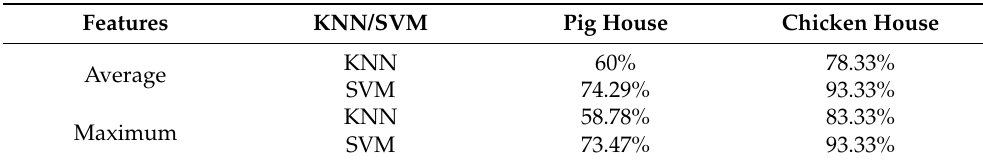
Table 8. The accuracy for odor classification in different sampling locations and different sampling times of pig and chicken